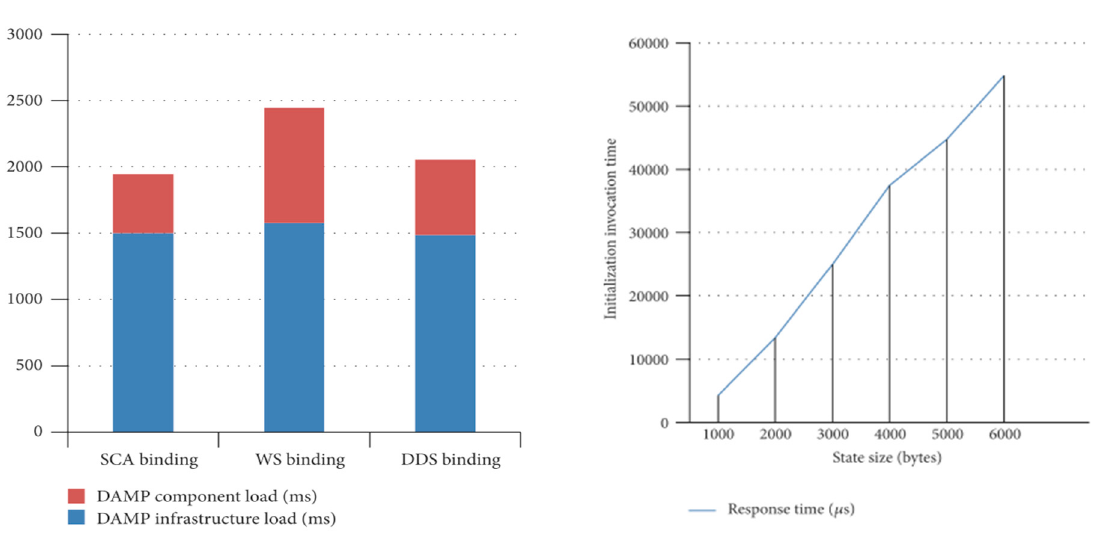
Figure 14 . Component instantiation and initialization time. Figure 14. Component instantiation and initialization